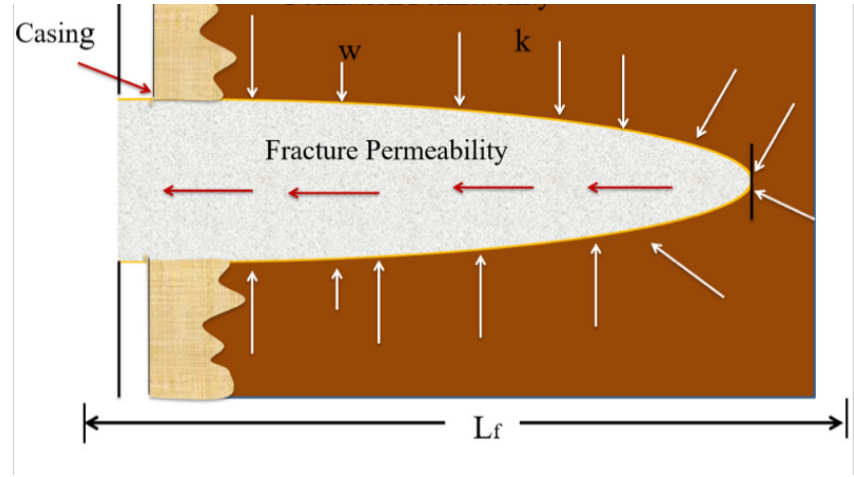
Figure 1. Schematic of fluid flow through a fracture.